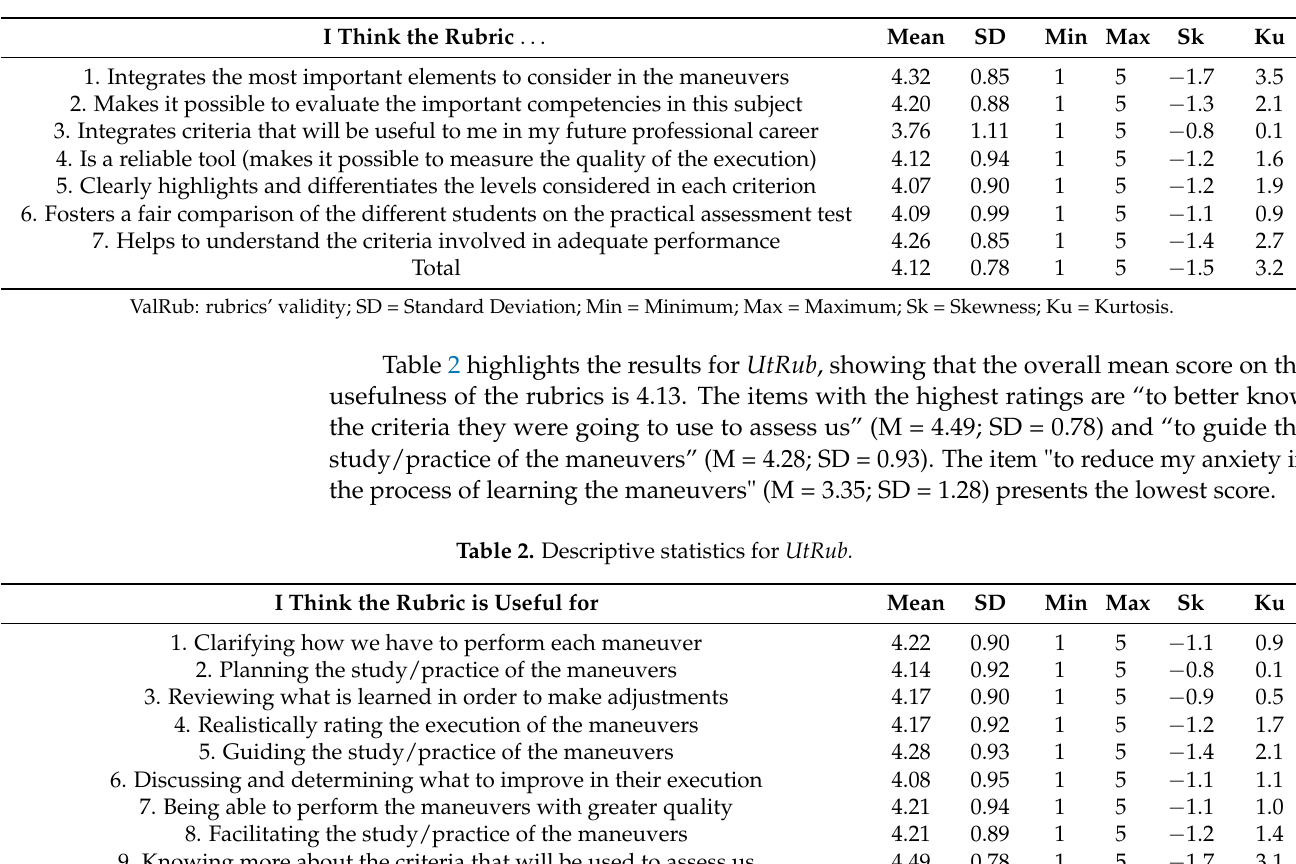
Table 1. Descriptive statistics for ValRub .